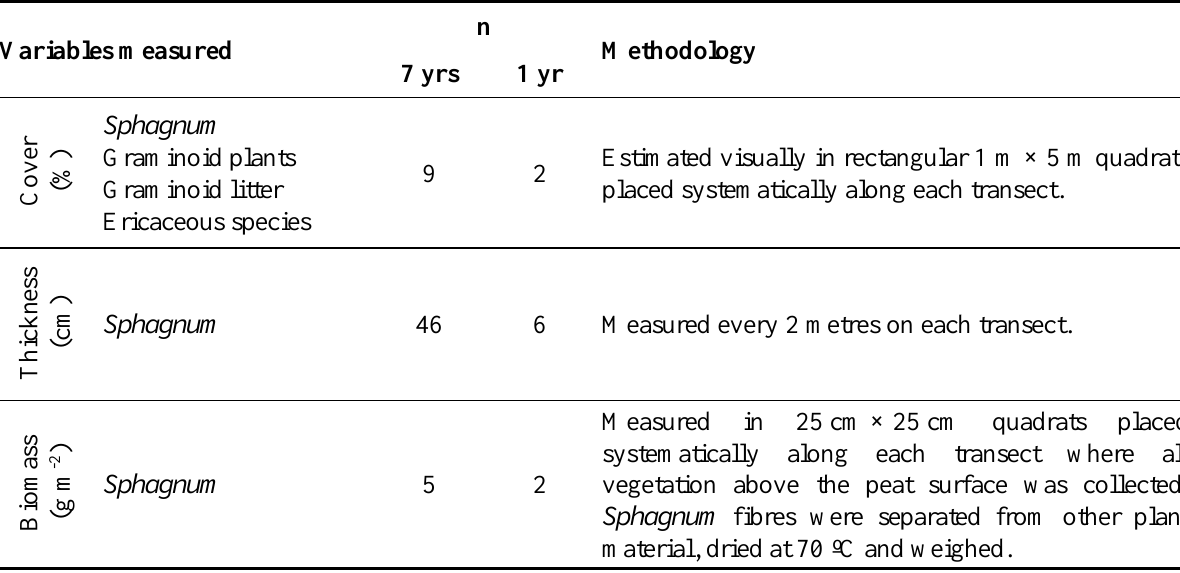
Table 1. Number of samples (n) for each variable measured per sub-plot in the Sphagnum farm experiment for each production cycle and a description of the